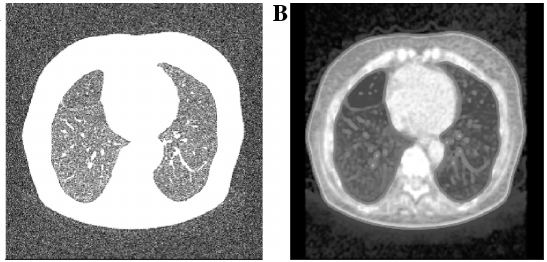
Figure 9: Analysis of Visual Quality of Restored Medical Image 2 (Gaussian Noise in σ = 50%). (A) Noisy image, (B) restored